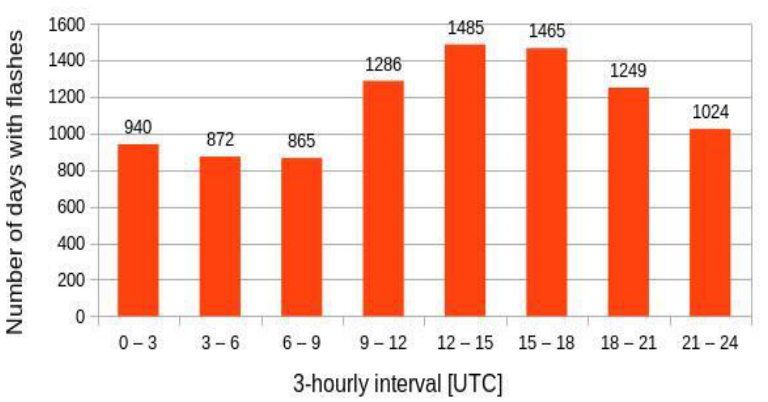
Figure 8. Number of days with detected flashes in the different diurnal time intervals during the period 2012 – 2021.